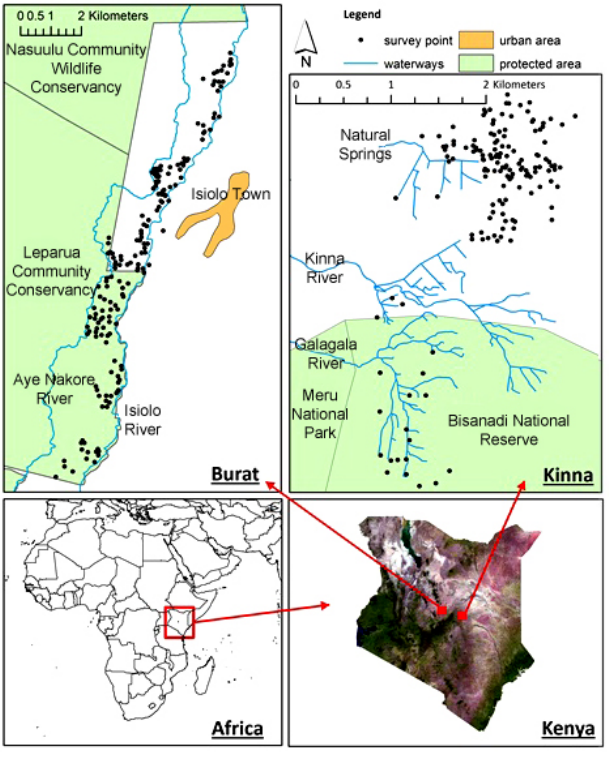
Fig. 1. Map indicating the locations of the study